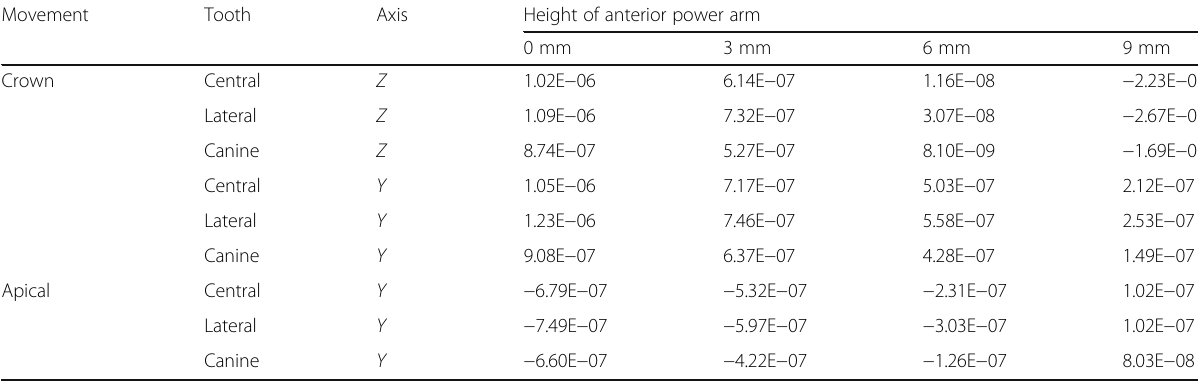
Table 4 Crown and root tipping in the mesial position of the mini screw Movement Tooth Crown